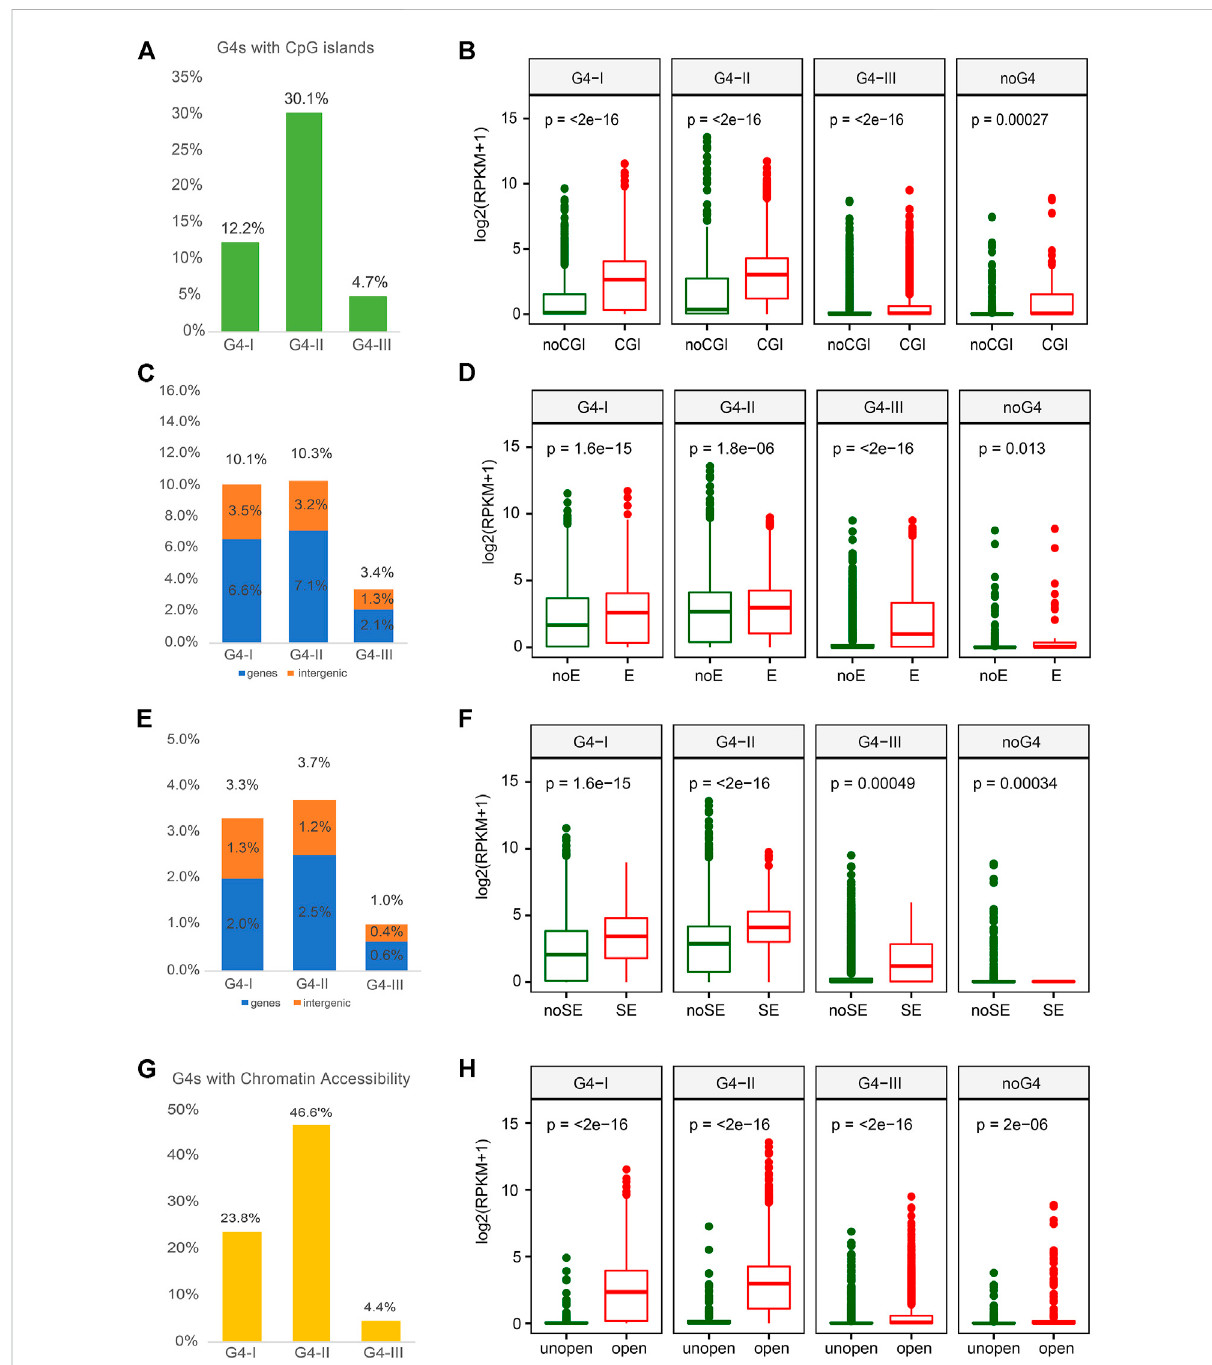
FIGURE 4 Overlaps between G4 groups and multiple epigenetic regulatory regions with corresponding gene expression. (A) Ratios of G4 groups overlapping with CpG island (CGI) and. (B) expression pro fi les for genes with three G4 groups or without any G4 in or out of CGI. (C) Ratios of G4 groups overlapping with enhancer and. (D) expression pro fi les for genes with different G4 groups or without any G4 in or out of enhancer. (E) Ratios of G4 groups overlapping with SE and. (F) expression pro fi les for corresponding genes comparing to the SE. (G) Ratios of G4 groups overlapping with open chromatinregions and. (H) expression pro fi les for genes with three G4 groups or without anyG4 inor out ofchromatin open